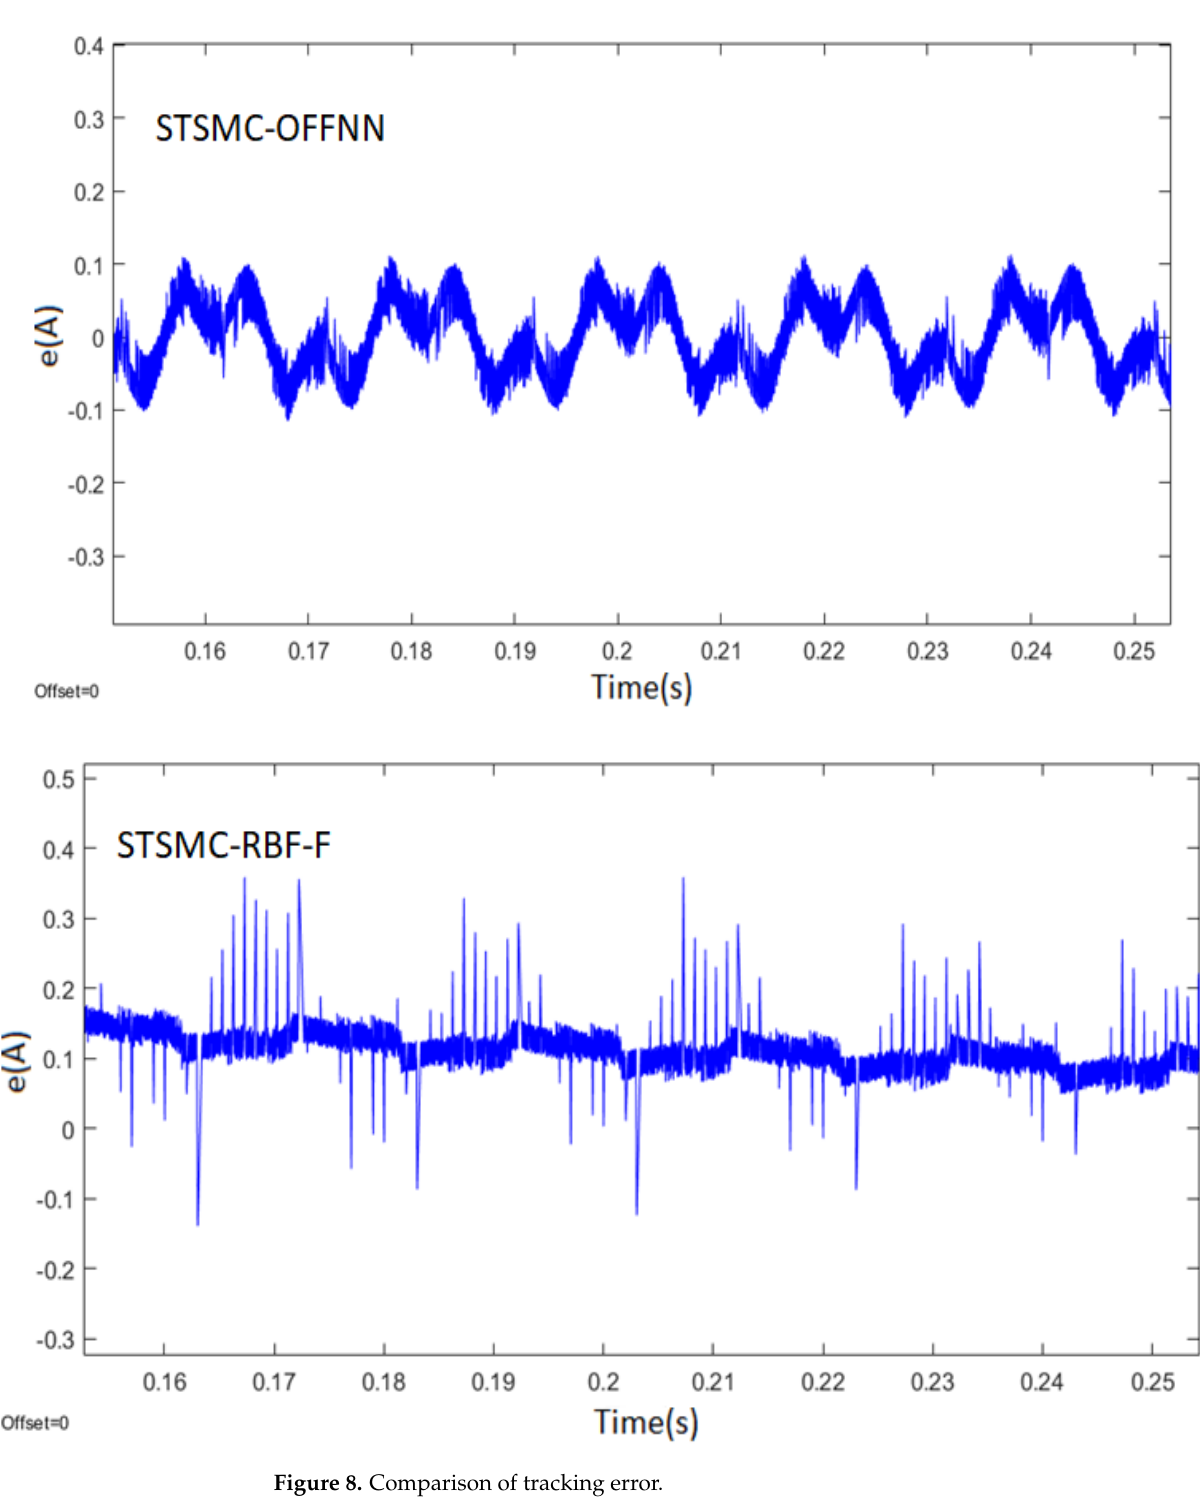
Figure 8. Comparison of tracking error.